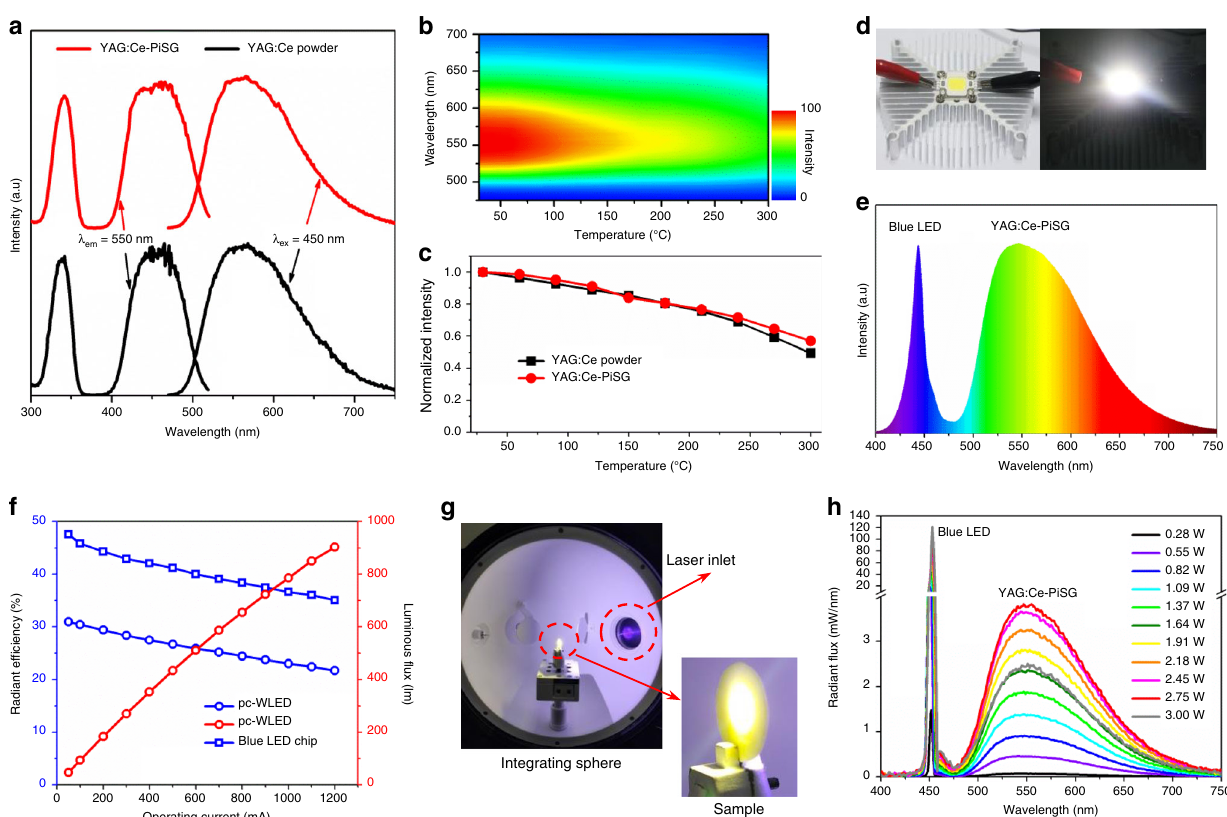
Fig. 2 Optical characterization of YAG:Ce-PiSG fl at discs. a Excitation and emission spectra of 5 wt% YAG-PiSG and YAG:Ce powder. b Temperature- dependent emission spectra of 5 wt% YAG:Ce-PiSG. c Temperature dependences of the integrated emission intensity of 5 wt% YAG:Ce-PiSG and YAG:Ce powder. d Photos of the as-fabricated pc-WLED (10 W) (left) and the lighted one in the darkness (right). e Electroluminescence spectrum of pc-WLED under the current of 50 mA. The correlated color temperature (CCT), the CIE coordinates and the color rendering index ( R a ) is 4586 K, (0.3702, 0.4378) and 62, respectively. f The operating current dependences of the luminous fl ux of pc-WLED and the radiant ef fi ciencies of blue LED and pc-WLED. g The experimental setup in the integrating sphere for characterizing the tolerance of high-density blue radiation of 5 wt% YAG:Ce-PiSG. Note that no heat sink is used here. h Luminescence spectra of 5 wt% YAG:Ce-PiSG (1 cm in diameter, 0.6 mm in thickness) under various laser optical Under 450 nm excitation, the IQE of 5 wt% YAG:Ce-PiSG is